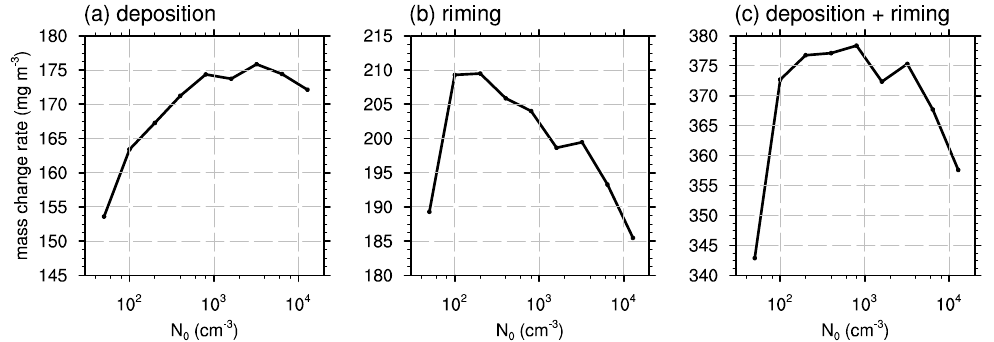
Figure 12. Mass change rates due to ( a ) deposition, ( b ) riming, and ( c ) the sum of deposition and riming as functions of N 0 , averaged vertically from the surface to z ~15 km.